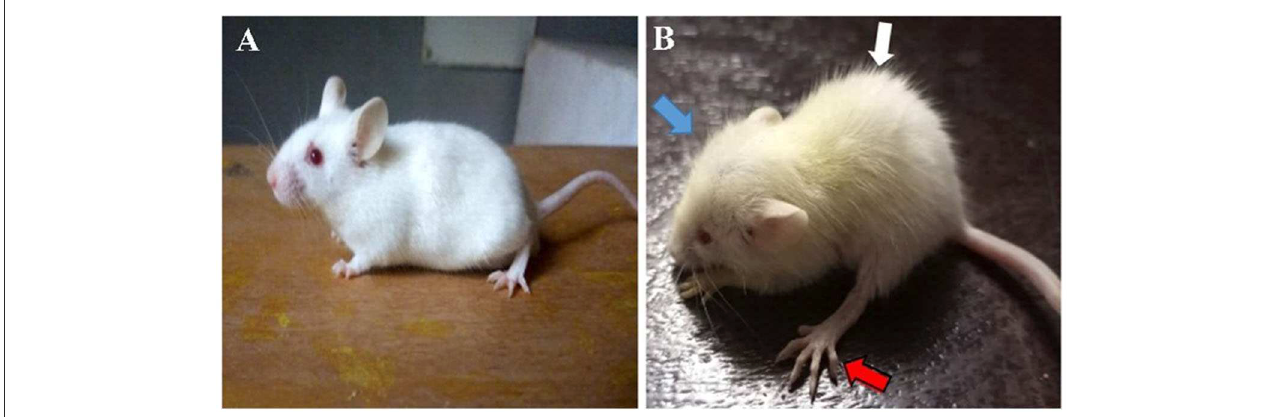
FIGURE1 Photographs of control (A) and hydrocephalic mice (B) . Hydrocephalic mouse presents with a dome-shaped head (blue arrow), hunched back (white arrow), flat placement of limb (red arrow) and scruffy fur compared to the control mouse.